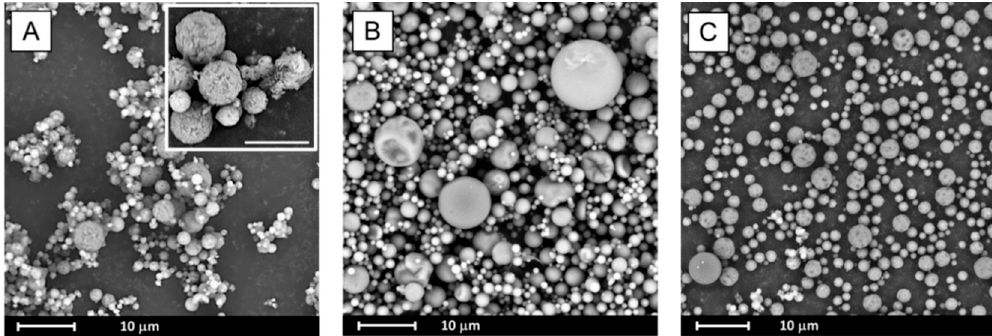
Figure 4. Scanning electron microscopy (SEM) images of spray dried systems: BCL ( A ), BCL–PVP 2:1 ( B ) and BCL–PVP 1:1 ( C ). Scale bar in the insert is 5 μ m.